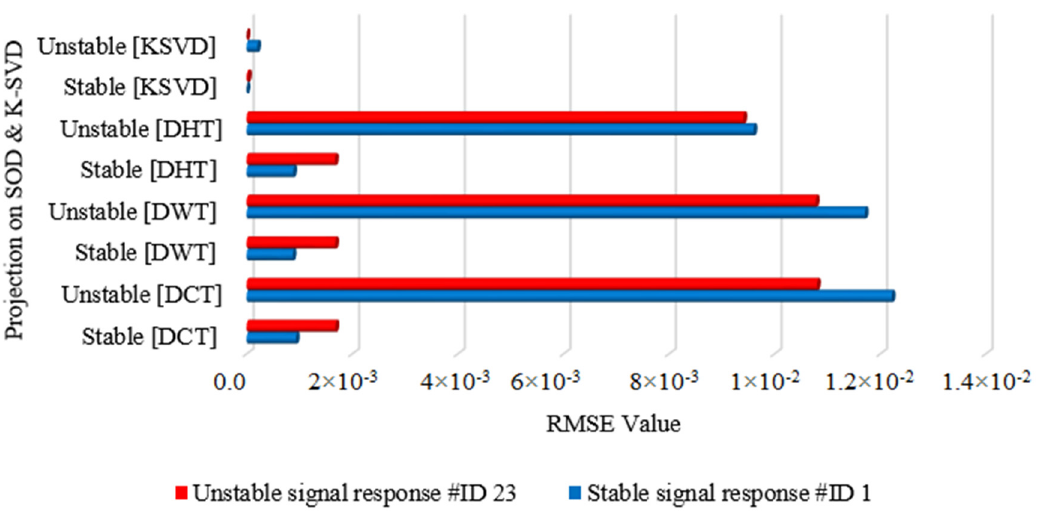
Figure 7. Projections of signals ID 1 and ID 23 on stable and unstable SOD and ADL.